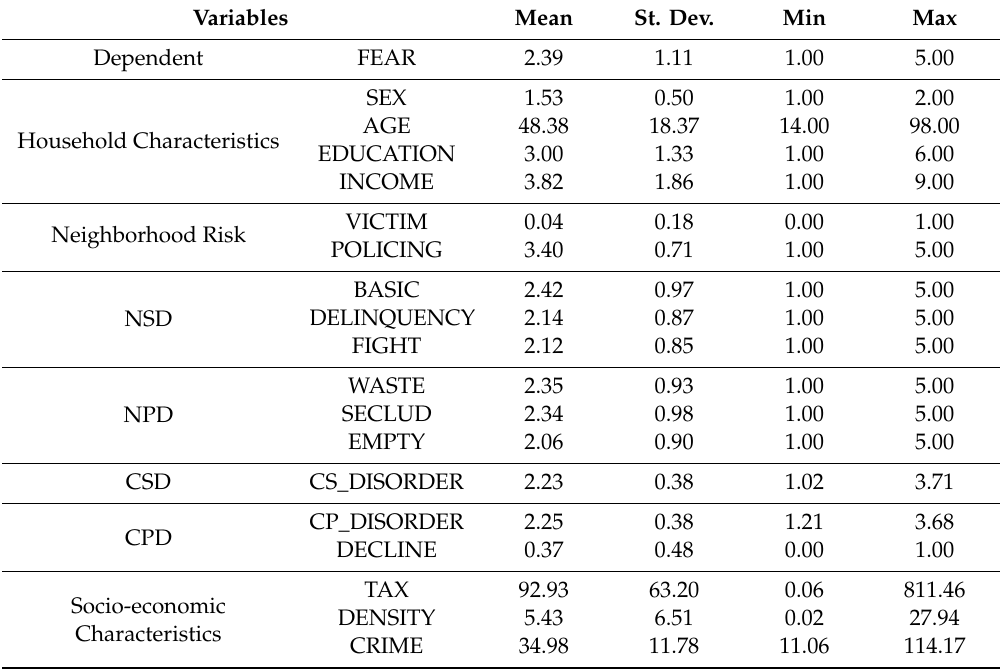
Table 5. Results of descriptive